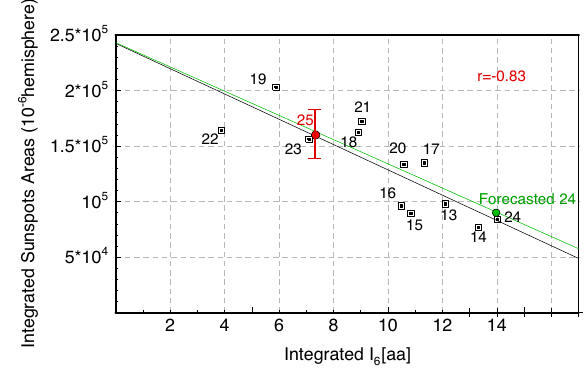
Fig. 1. Linear regression (black line) of I 6 [ aa ] integrated over the descending phase of each solar cycle versus the integrated sunspot area over the following cycle. The expected values of integrated sunspot area for SC 25 are represented by the red circle (con fi dence level is obtained as root mean square error). Green circle represents the SC 24 forecasted at the end of SC 23 by using the regression from Diego et al. (2010) (represented by the green line) over SCs from n. 14 to